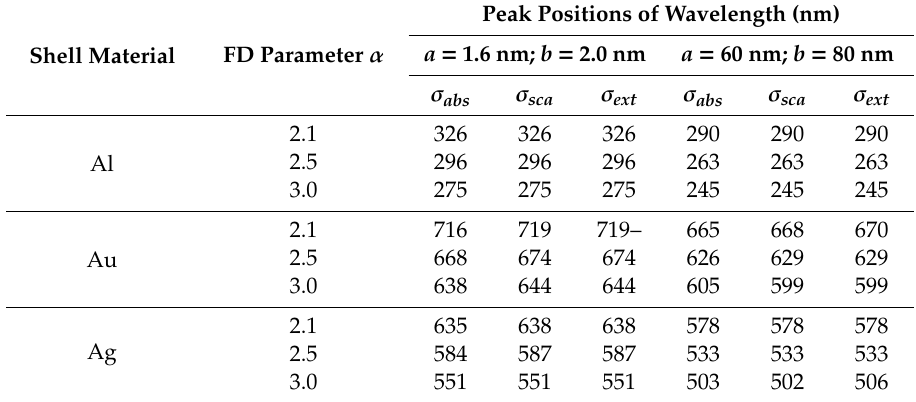
Table 1. Resonance peak positions as observed corresponding to the scattering and absorption cross-sections, and also, the extinction coe ffi cients (as discussed in Figures